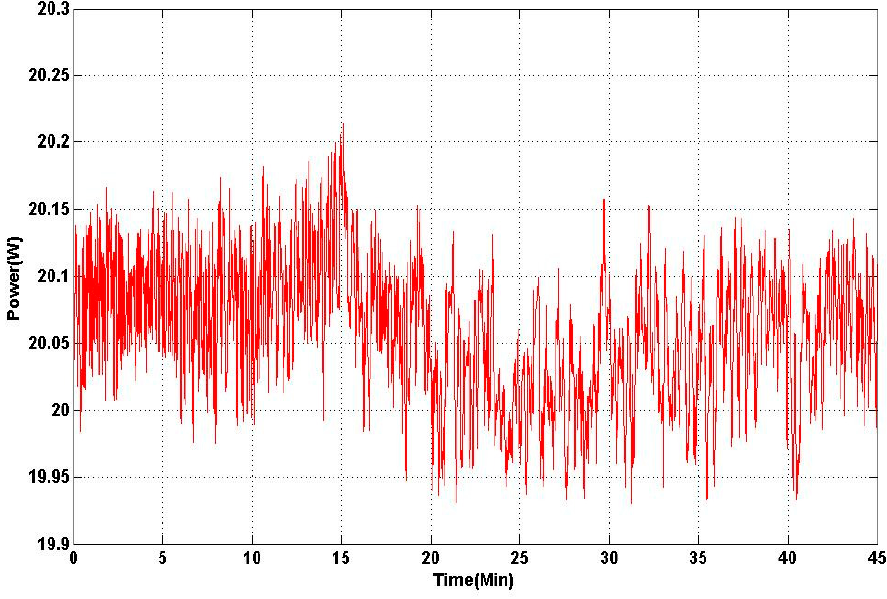
Figure 8. Output power jitter in 45 minutes.